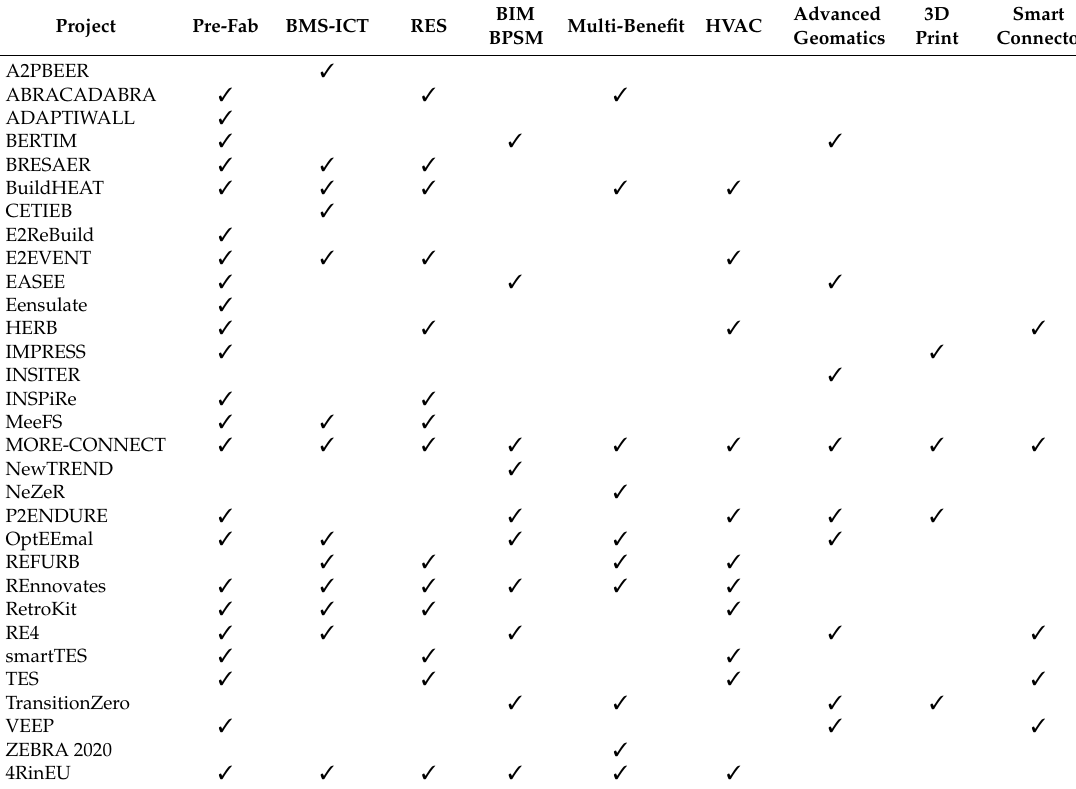
Table 3. Key state-of-the-art technologies for the reviewed EU-funded projects that deal with pre-fab systems for deep